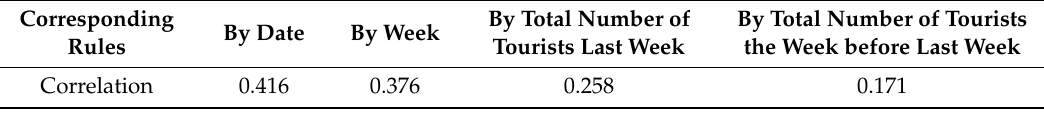
Table 2. Results of correlation